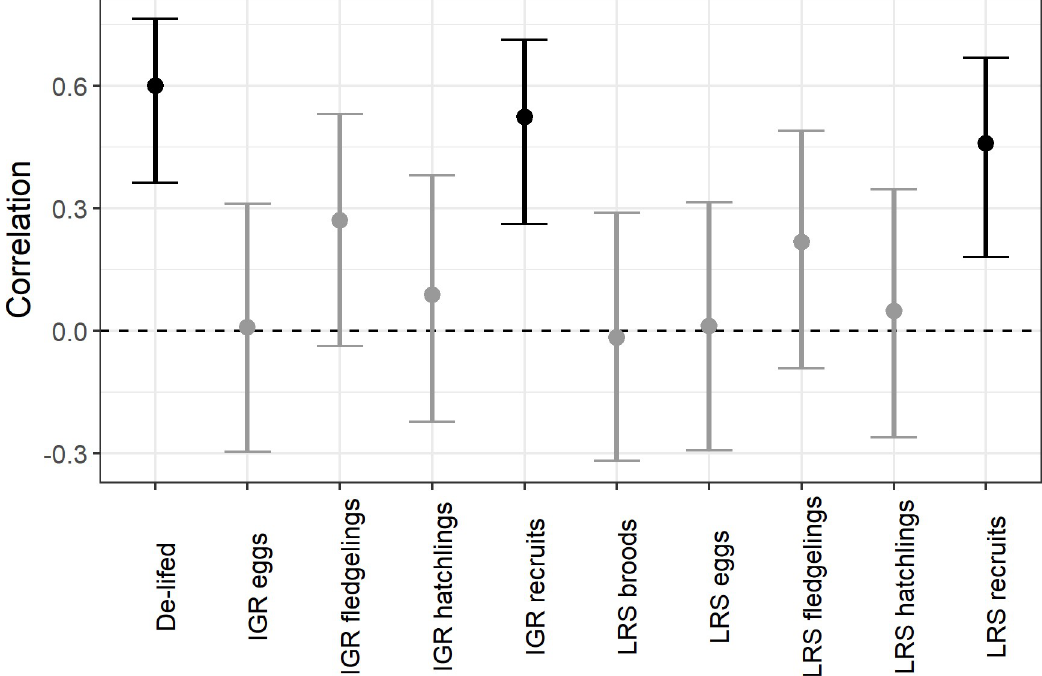
Fig 2. Correlation between each of the fitness proxies at different life stages with reproductive value. Error bars represent 95% confidence intervals. Black bars represent significant results, while light grey bars represent non-significant results.